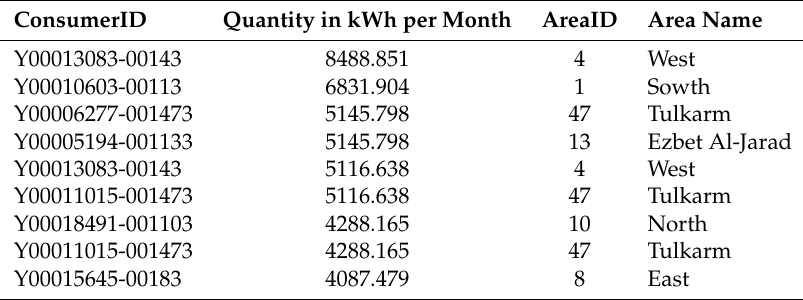
Figure 10. Outliers detection of electricity consumption in kWh per month. Table 2. List of household consumers considered as an